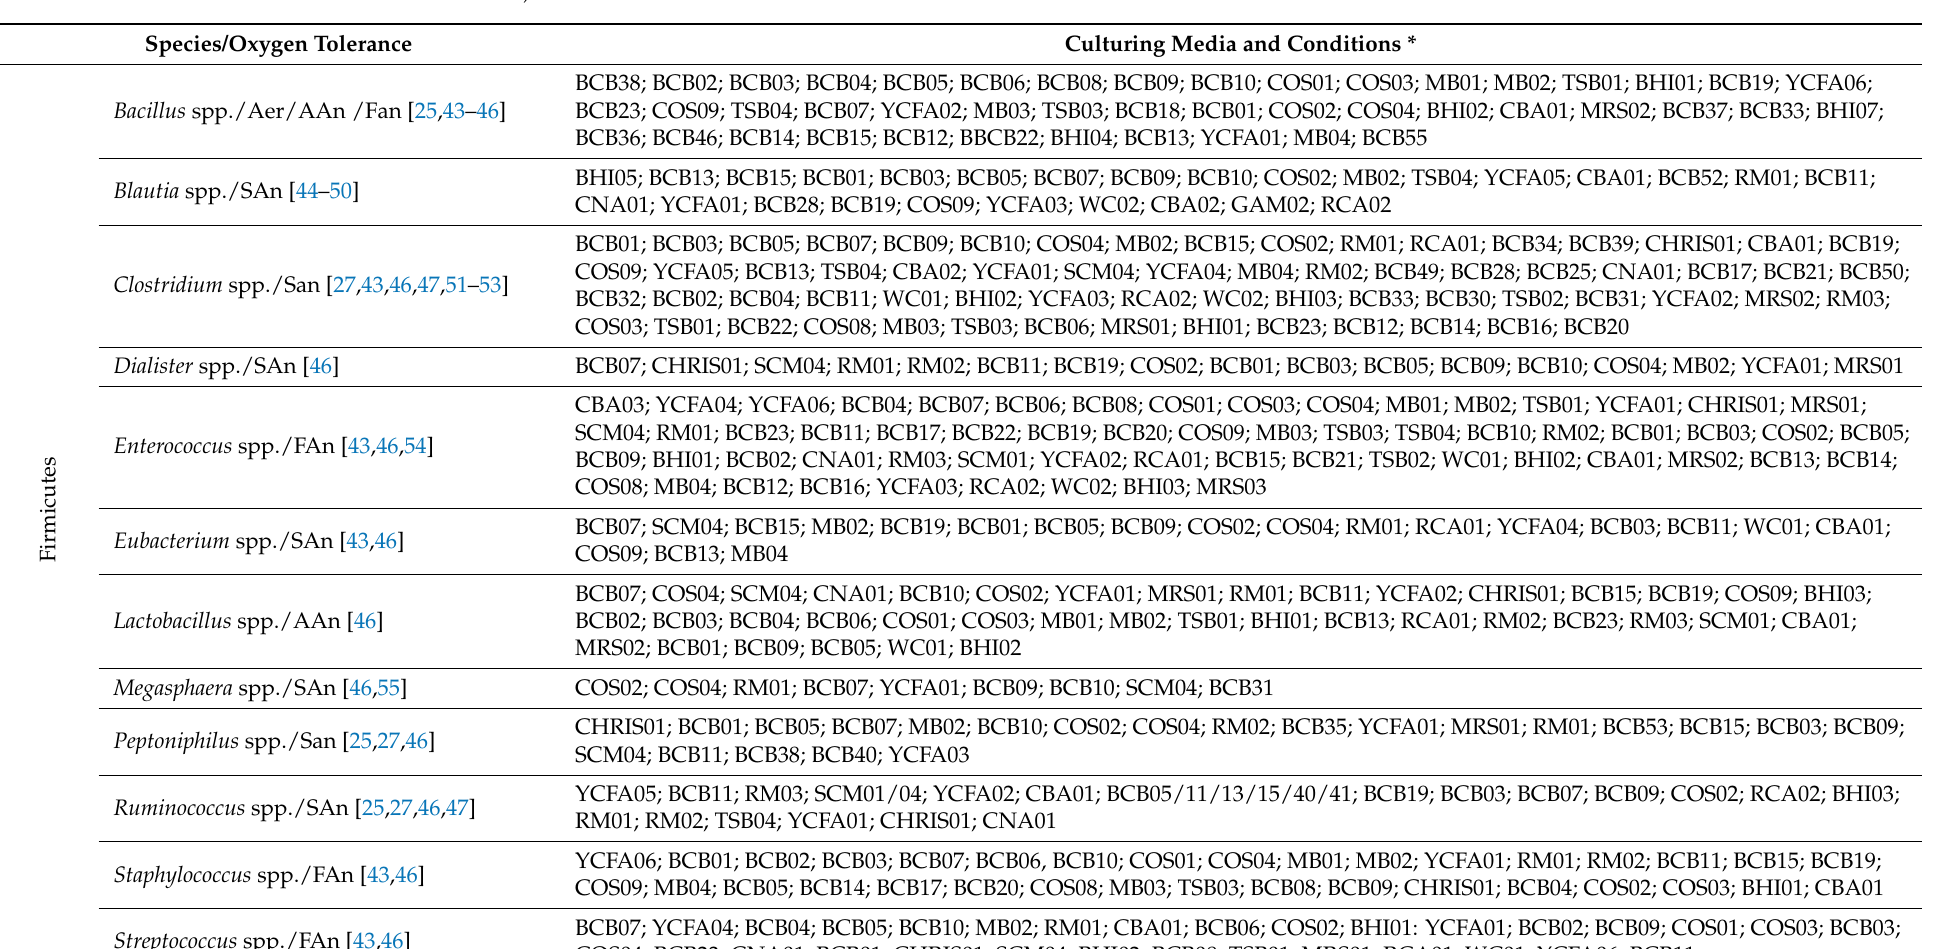
Table 1. Culturing media and conditions for isolation of microbiota taxa components (Aer: aerobic; AAn: aerotolerant anaerobe; SAn: strictly anaerobic; FAn: facultative